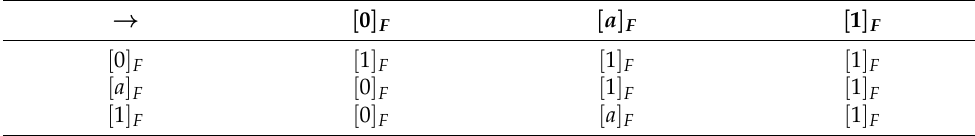
Table 16. The operation → on L / ∼ F